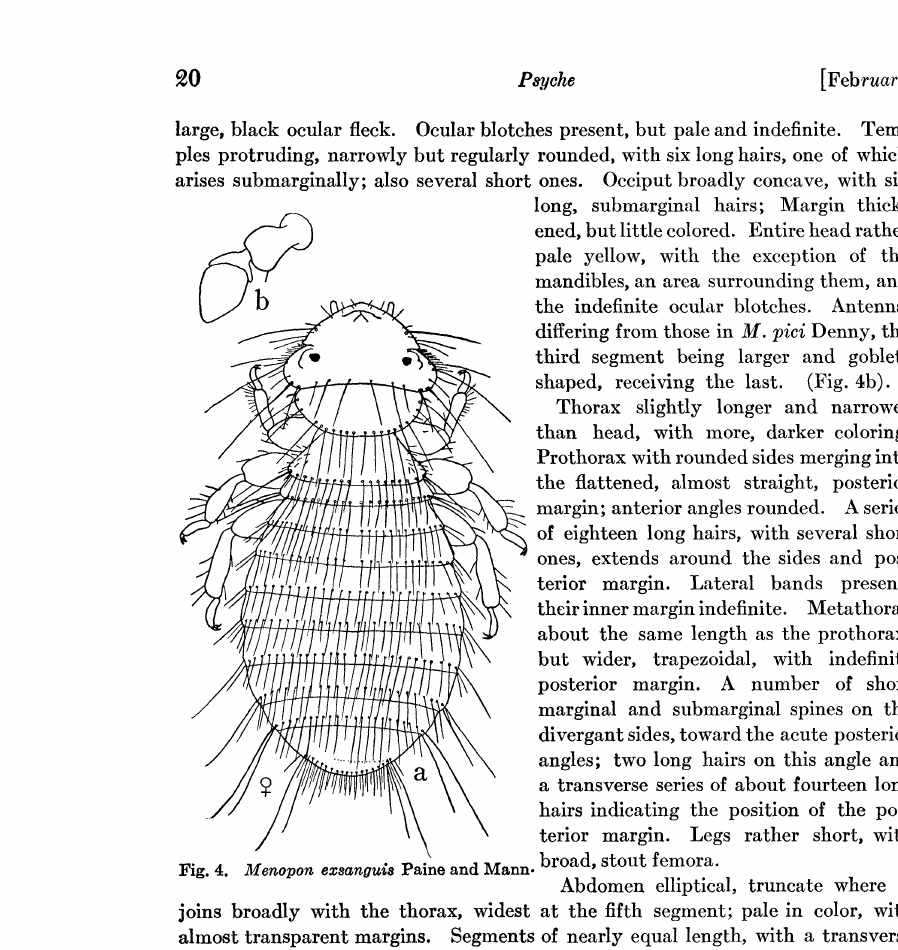
broad, stout femora. Fig. 4. Menopon exsanguis Paine and Mann. Abdomen elliptical, truncate where it joins broadly with the thorax, widest at the fifth segment" pale in color, with almost transparent margins. Segments of nearly equal length, with a transverse row of from twenty to thirty strong hairs. Last segment rounded, but somewhat triangular in shape, with about twenty hairs around the margin, the anterior ones of which are quite long; on the ventral surface are two fringes of fine hairs. Male varying in size, the largest one being but little smaller than the female. Last segment similai’ in shape to that of the female, but with fewer hairs and lacking the ventral fringes. Genitalia prominent, consisting of a broad anterior portion and long, slender lateral